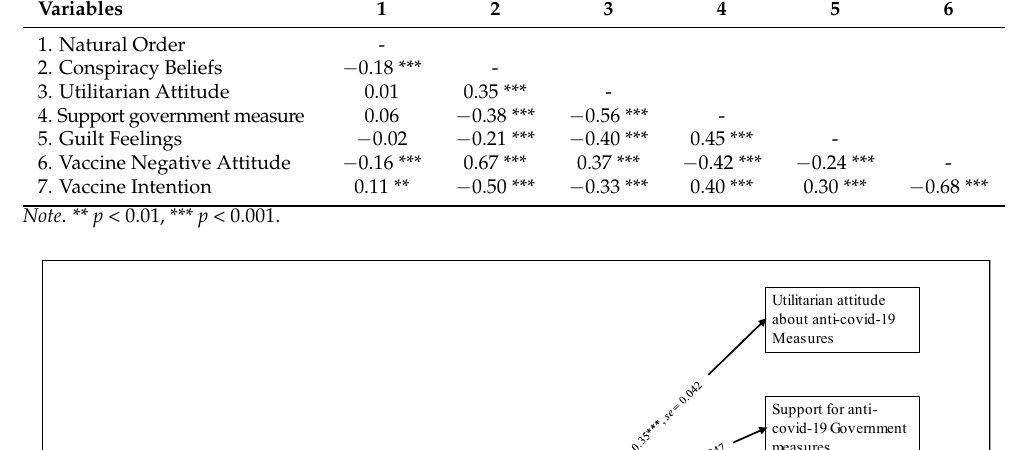
Table 3. Results of Path Analysis Model.